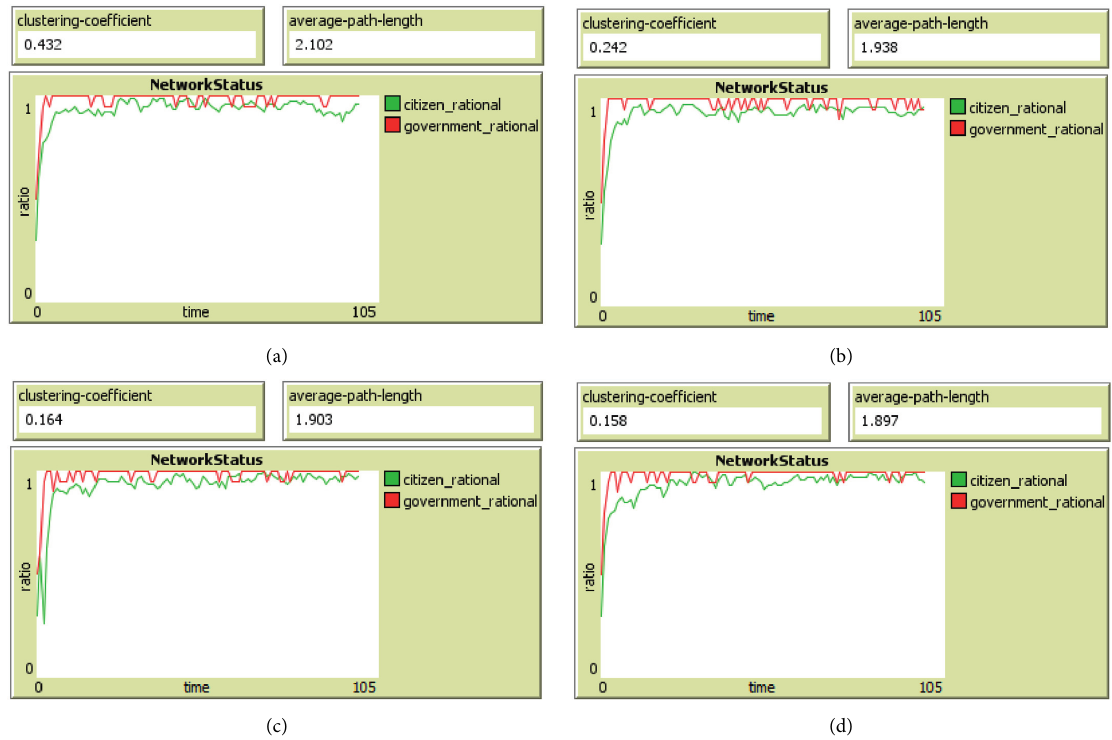
Figure 7: The evolutionary result when the reconnection probability p takes different values in scenario three: (a) the evolutionary result when p � 0.2; (b) the evolutionary result when p � 0.4; (c) the evolutionary result when p � 0.6; (d) the evolutionary result when p �